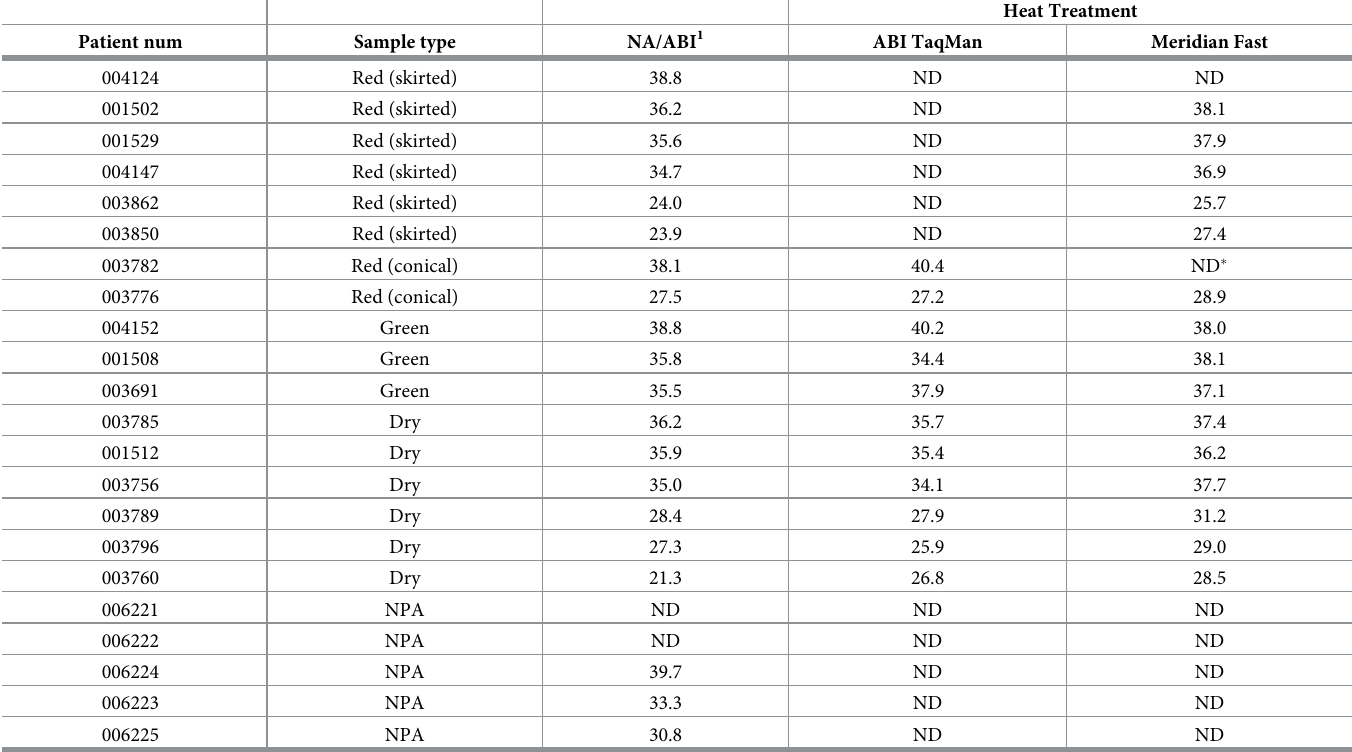
Table 2. Assessment of transport medium on SARS-CoV-2 detection using two RT-qPCR mixes following a 5min heat treatment at 95˚C and 5min at